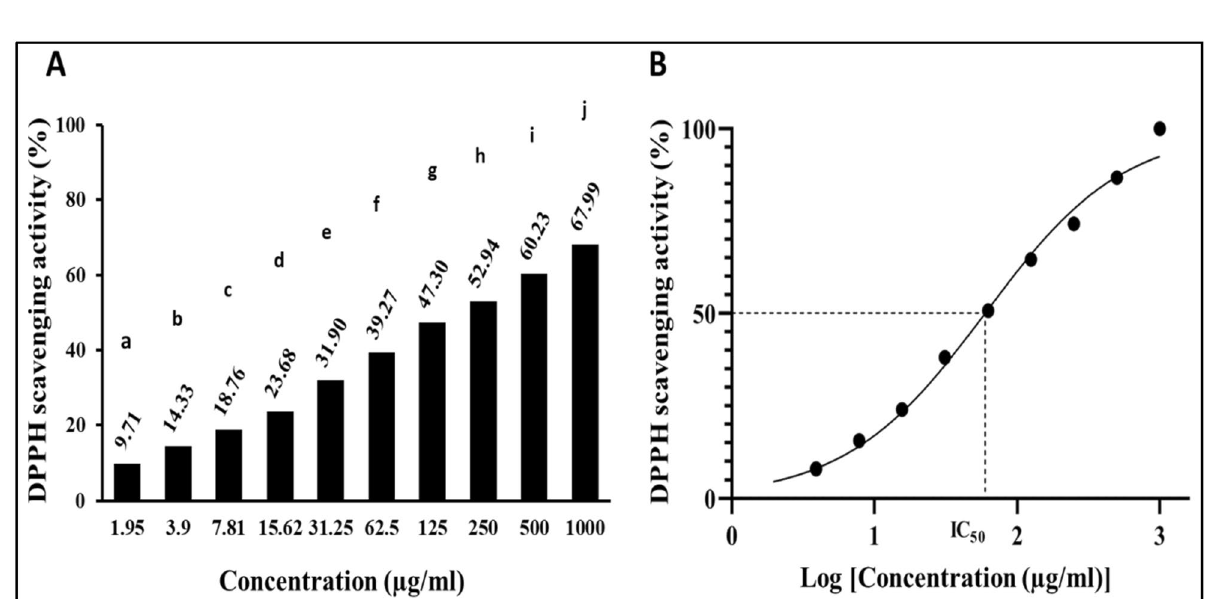
Figure 8. ( A ) Antioxidant activity of Kocuria sp. RAM1 carotenoids. The letters from a to j represent significant differences among different homogeneous subsets identified by the post hoc test for p < 0.05. ( B ) IC 50 estimation. The data represent the mean ± SD (n =